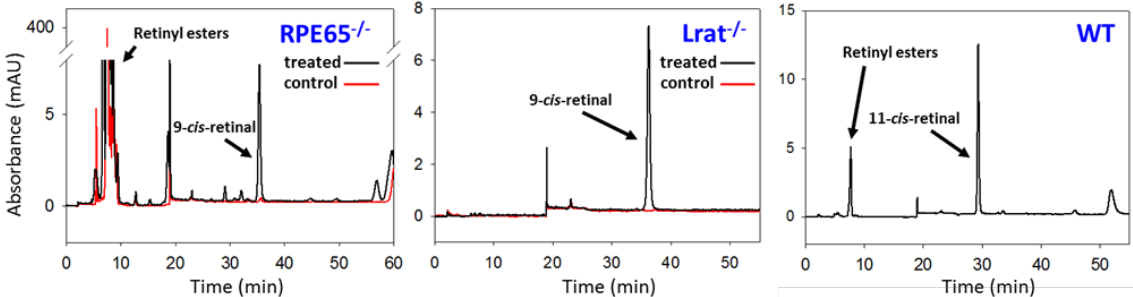
Figure 5. Normal phase HPLC analysis of retinoids in dark adapted mouse models of retinal degeneration. Concentrations of cis -retinoids and retinyl esters in the retina differ before and after 9- cis -retinoid treatment. Control Rpe65 knockout mice exhibit significantly increased concentrations of retinyl esters and are devoid of 11- cis -retinal. Rpe65 −/− mice treated with 9- cis -retinoids show increase 9- cis -retinal bound to rhodopsin. Likewise, untreated Lrat knockout mice lack both 11- cis -retinal and retinyl esters, while treated Lrat knockout mice show an increase 9- cis -retinal bound to rhodopsin. WT